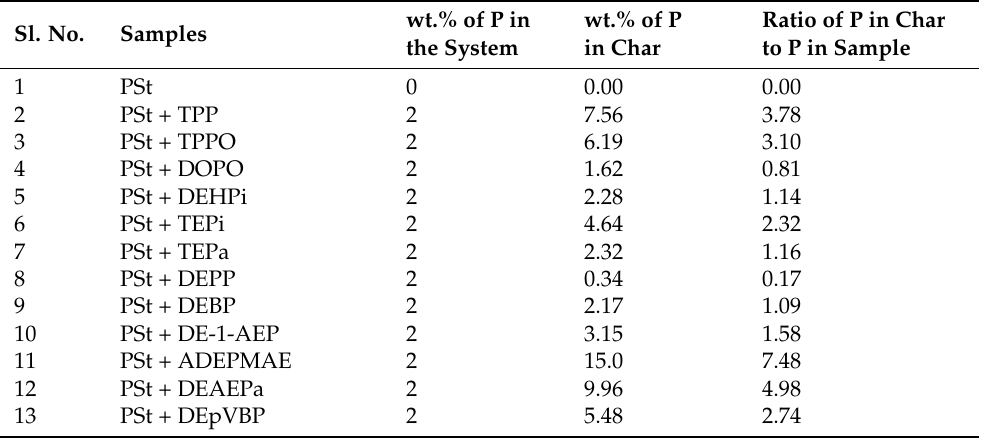
Table 4. Phosphorus contents of the unburned samples and char residues of PSt-based materials.